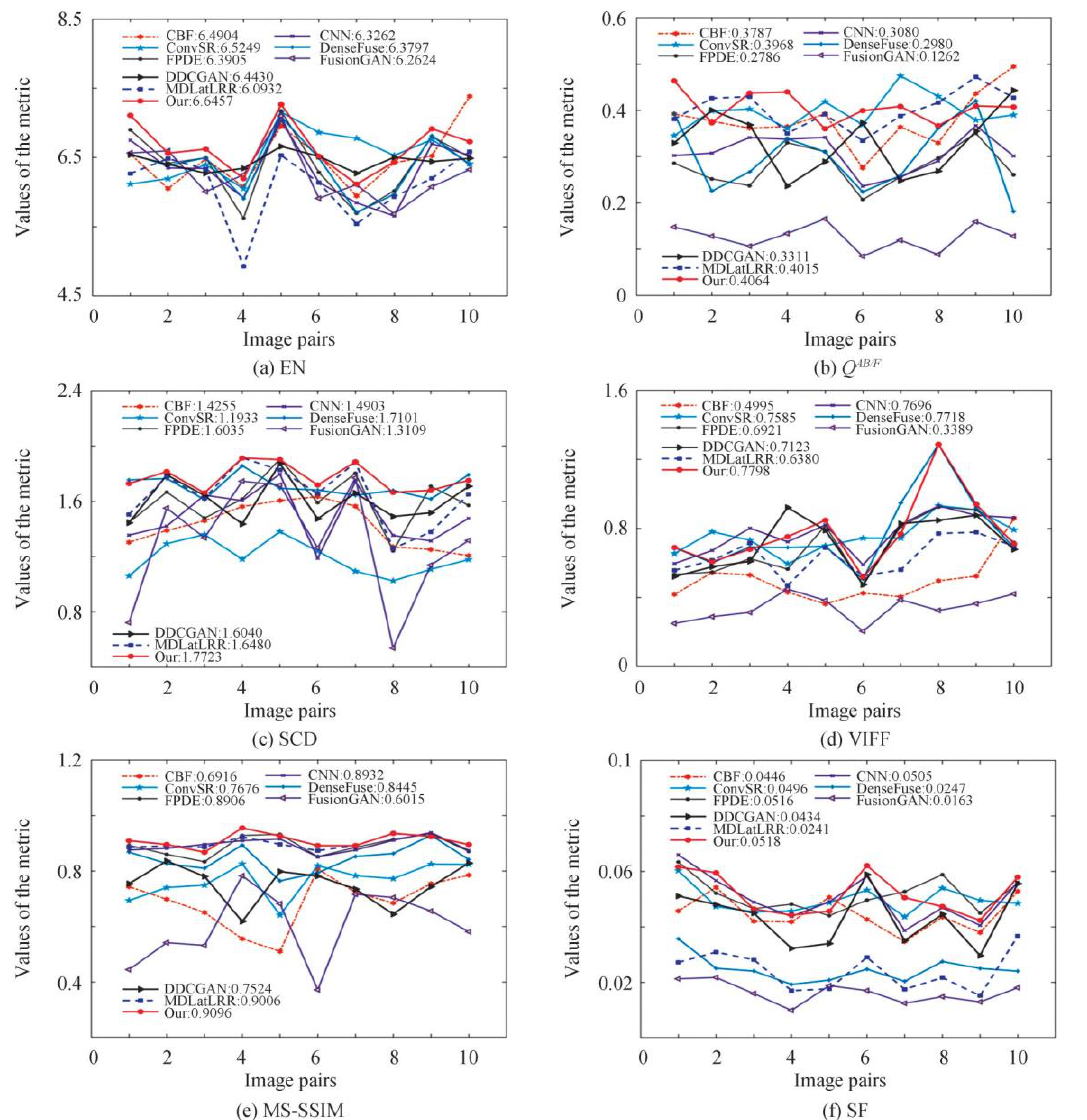
Figure 7. Comparison of six objective metrics for different